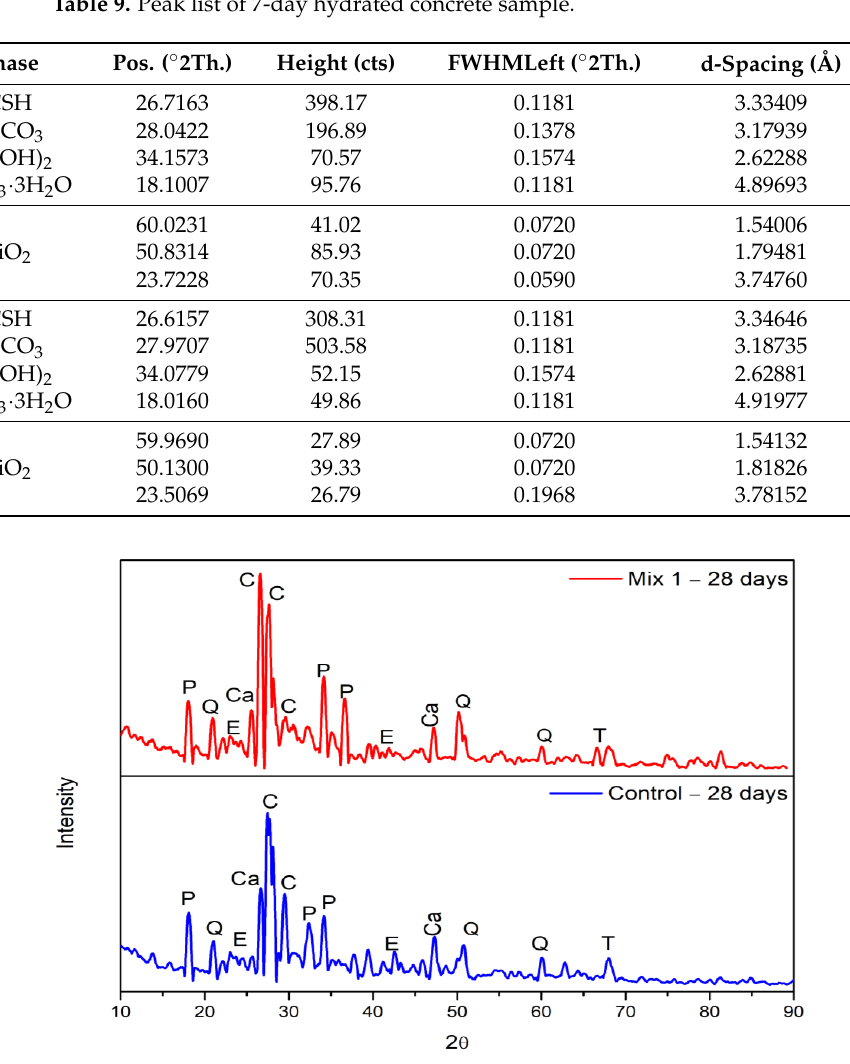
Figure 10. XRD of 28-day hydrated samples (Mix 1 and control). Table 10. Peak list of 28-day hydrated concrete sample.